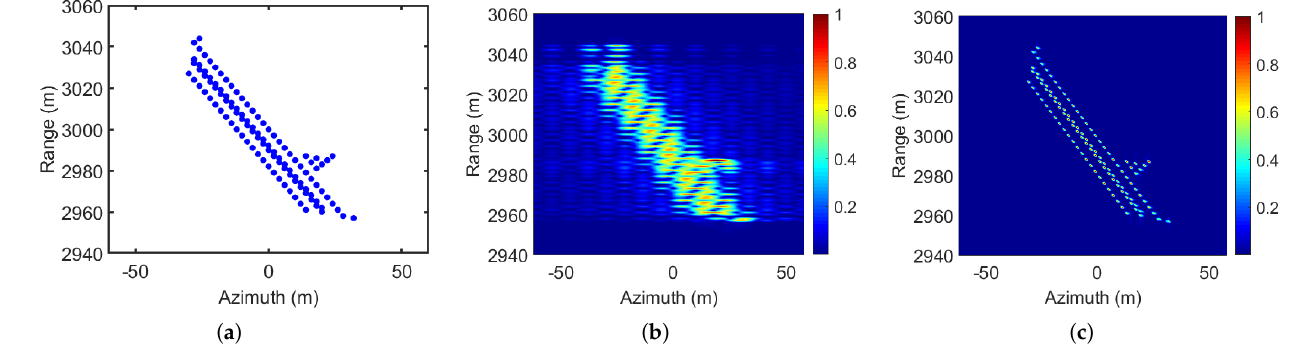
Figure 7. ( a ) Ship target model. ( b ) BP imaging result. ( c ) CS imaging